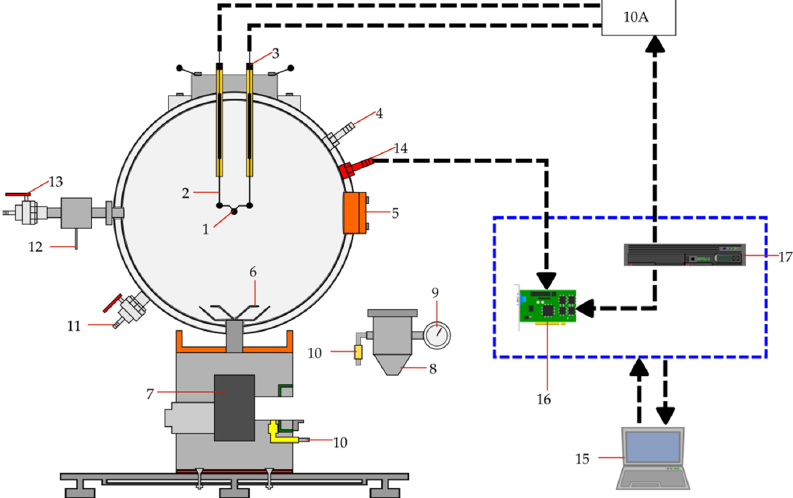
Figure 6. Scheme of standard 20 L dust-explosion vessel [7]: (1) chemical igniter, (2) electrode, (3) ignition leads, (4) water inlet, (5) inspection window, (6) nozzle, (7) fast-acting valve, (8) dust chamber, (9) pressure gauge, (10) pressure line, (11) water outlet, (12) vacuumized line, (13) exhaust valve, (14) pressure sensor, (15) PC, (16) data-acquisition card, and (17) time controller. The minimum ignition temperature of the tobacco dust cloud was determined by using the equipment presented in Figure 7. The central part of the Godbert–Greenwald furnace (MAIT/MIT, Anko, Warsaw, Poland) was an open-bottom silica tube with a diameter of 3.9 cm and a height of 23 cm. This tube was heated to the desired temperature with a device that controls the temperature of the furnace [21]. The tests confirmed that the temperature distribution of the furnace tube was homogeneous. During each experiment, compressed air was introduced into the tube at pressures of 10, 20, 30, and 50 kPa to create a dust cloud. Tobacco dust loads in measurements of 0.1, 0.2, and 0.3 g, and 0.5 g were used. The first measurement was made at 500 ◦ C, a weight of 0.3 g, and pressure of blown air of 30 kPa. The dust mass of tobacco at which the highest flame intensity was observed was determined.